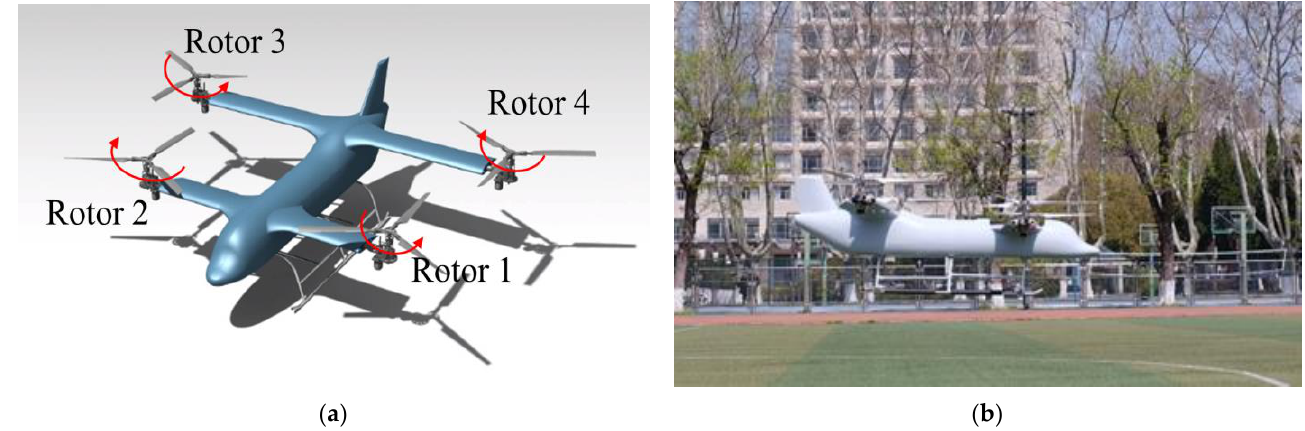
Figure 1. Configuration of the QTR. ( a ) Three-dimensional model of QTR. ( b ) Hover state of QTR flight test.